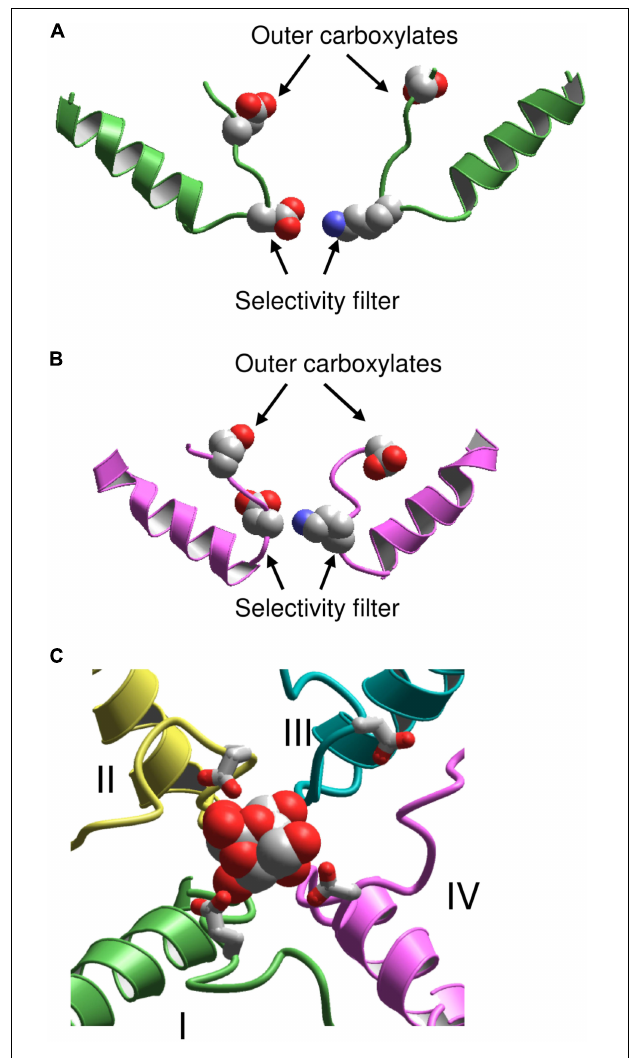
FIGURE 2 | KcsA-based models of sodium channels. (A) Model (Lipkind and Fozzard, 2000) in which the P helices are shifted from the pore axis as compared with KcsA and the DEKA selectivity filter is located at the P-loop turn. (B) Model (Tikhonov and Zhorov, 2005a) in which the P-helices are disposed as in KcsA, and the DEKA ring is located in the middle of the ascending limbs. (C) Extracellular view at the TTX-bound model (Tikhonov and Zhorov, 2012). Repeats I, II, III, and IV are green, yellow, cyan, and magenta, respectively. The outer carboxylates are shown as